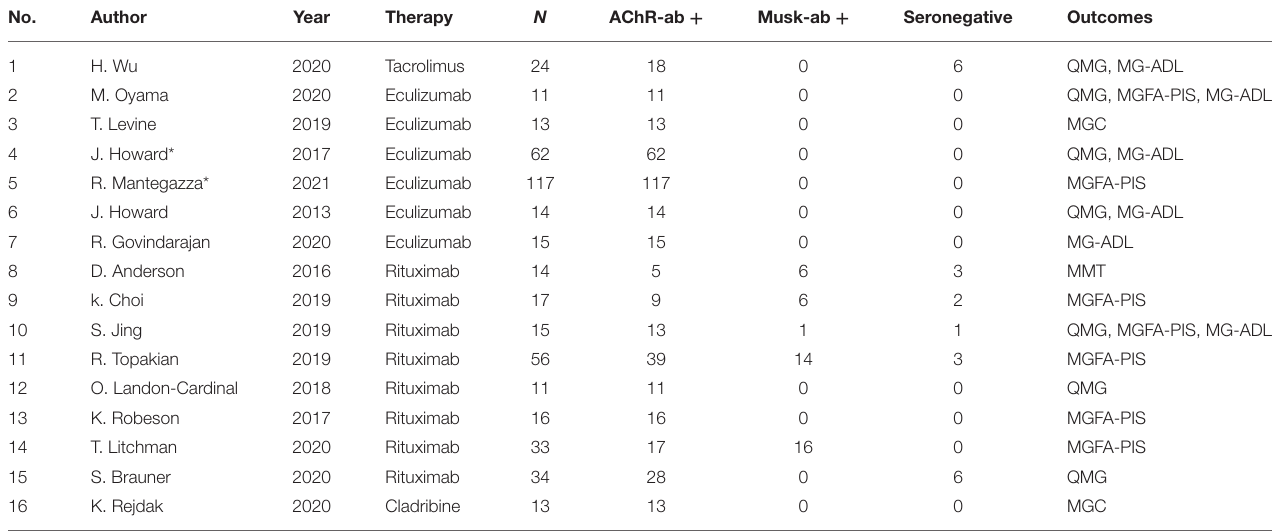
TABLE 1 | Summary of all the selected studies. No.